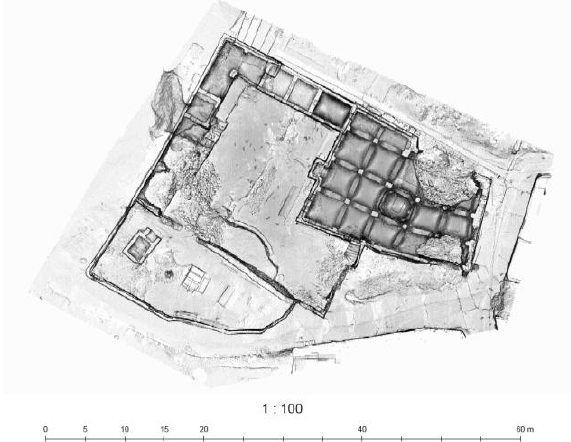
Figure 4. Plan of the whole object with Nahum´s shrine from